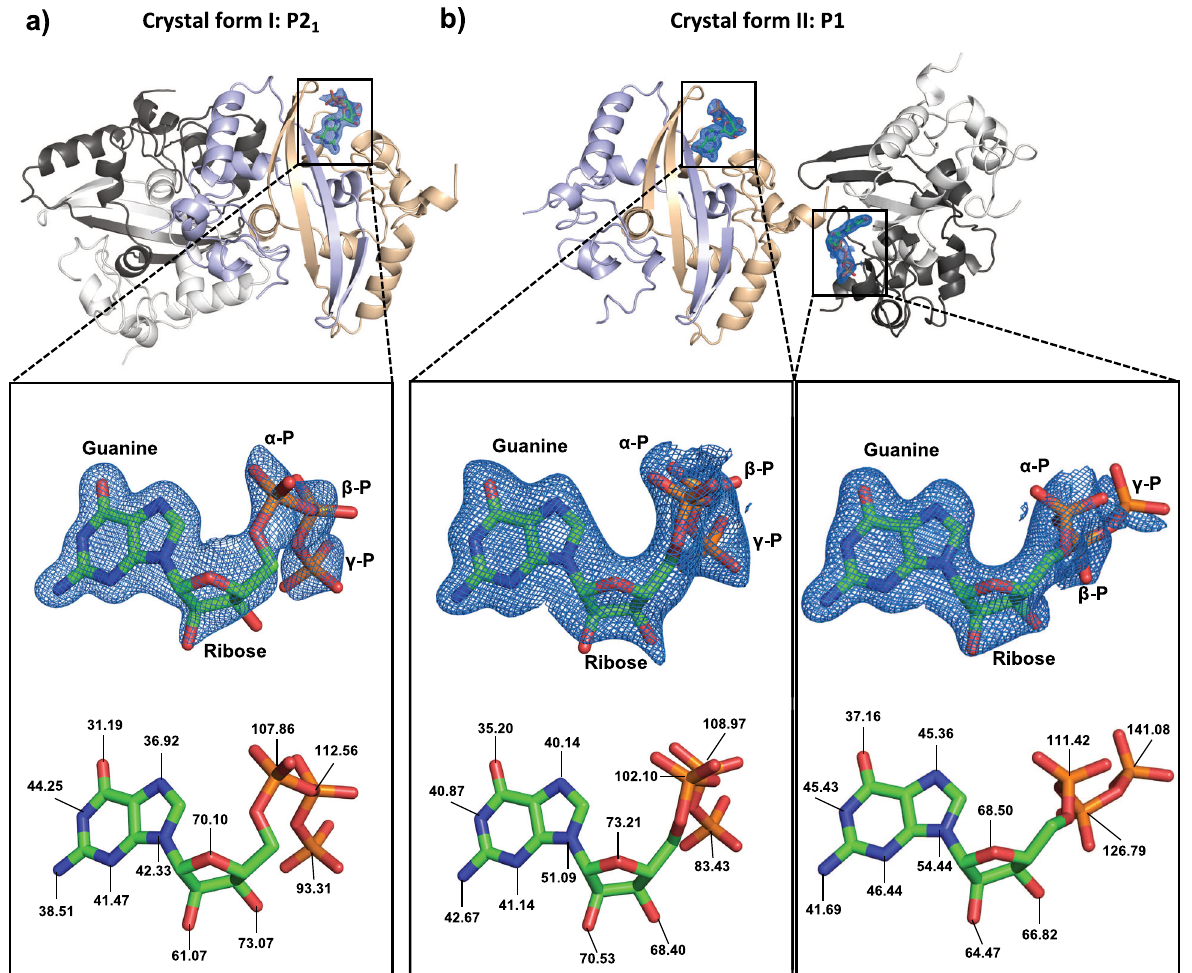
Fig. 2 Structures of SARS-CoV-2 NCTD in complex with GTP. Cartoon representation of the two dimers contained in the asymmetric unit of the crystal in the space group P2 1 ( a ) and P1 ( b ). Each monomer is colored in white and black for one dimer, and orange and blue for the second dimer. GTP is represented in sticks with carbon atoms colored green. The electron density map 2Fo − Fc ( σ = 1) of the GTP is represented in blue. The moieties guanine, ribose, and phosphates are labeled. Nitrogen, oxygen, and phosphorus atoms are colored in blue, red, and orange, respectively. The temperature factors ( B - factors) of nitrogen and oxygen atoms of the nucleoside and phosphorus atoms of phosphates are indicated